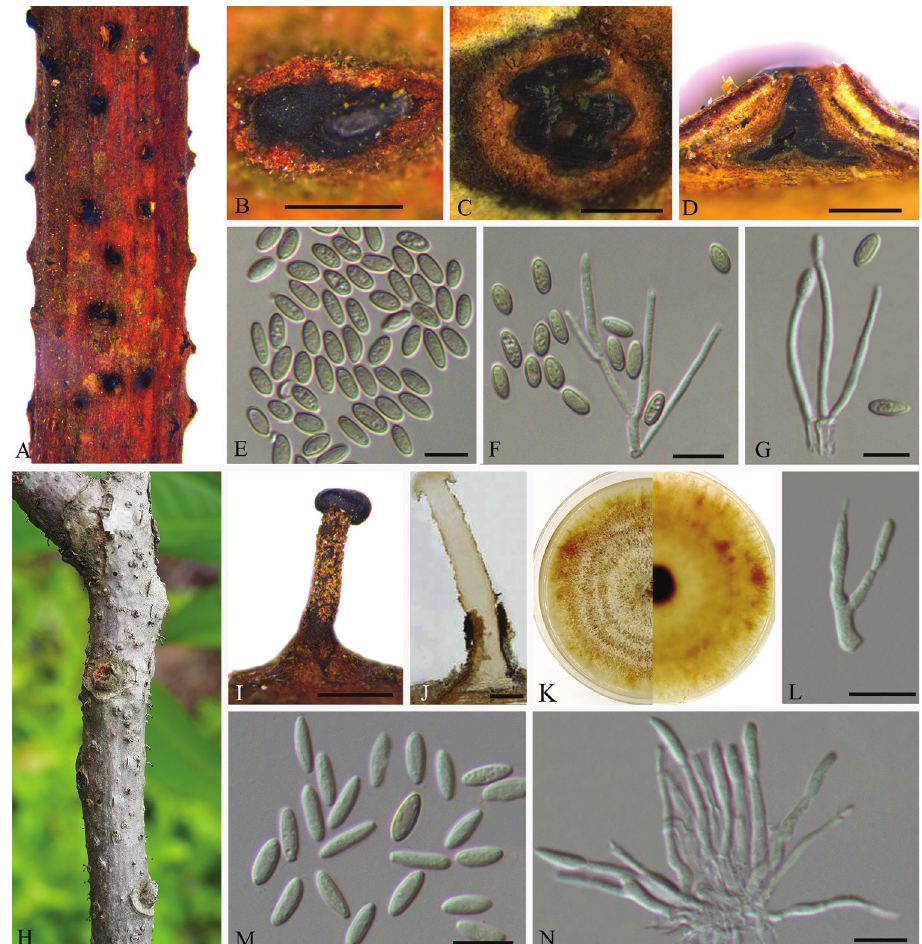
Figure 3. Asexual morphology of Synnemasporella aculeans on Rhus chinensis (BJFC-S1740) A, B habit of pycnidia on twigs C transverse section of pycnidium D longitudinal section through pycnidium E conidia F, G conidiogenous cells and conidia H, I habit of synnemata on twigs J longitudinal section through synnema K the colony on PDA L, N conidiogenous cells bearing conidia M conidia. Scale bars: 500 µm ( B–D, I, J ); 10 µm ( E–G, L–N slightly concave and dark zone of conidiogenous cells and host tissue at their bases. Co- nidiophores reduced to conidiogenous cells. Conidiogenous cells (12.5–)16–22(–25) × 2 µm, phialidic, aggregated, hyaline, straight to curved, cylindrical, arranged adjacent to one another at the end of the synnema, producing a single conidium. Conidia cylindri- cal to oblong, smooth, multiguttulate, hyaline, (5–)5.5–7(–8) × 1.5–2 µm. Culture characters. On PDA at 25 °C in darkness, initially white, becoming olive- green to black after 3 wk, zonate with 3–4 well defined zones. Conidiomata distributed concentrically over agar surface.